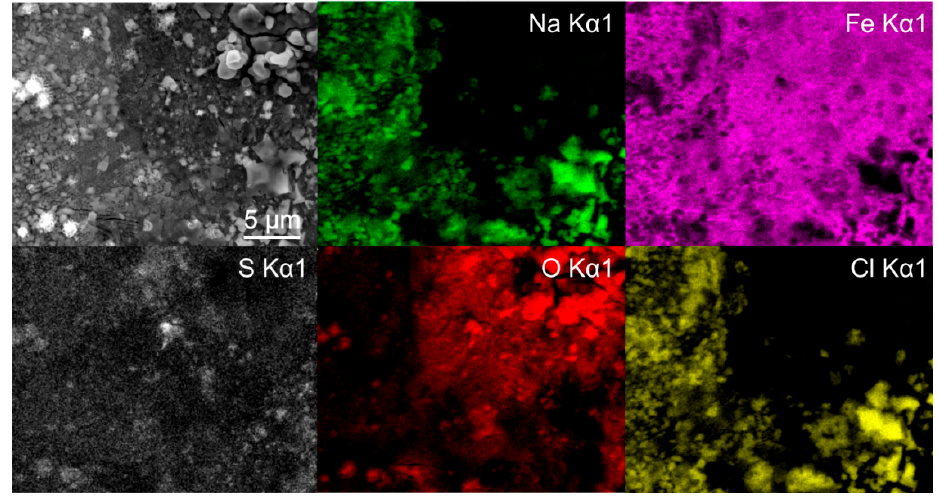
Figure 3. Energy dispersive X-ray spectroscopy mapping of deep cryogenic heat-treated (DCT) steel Y after 1 day immersion time.